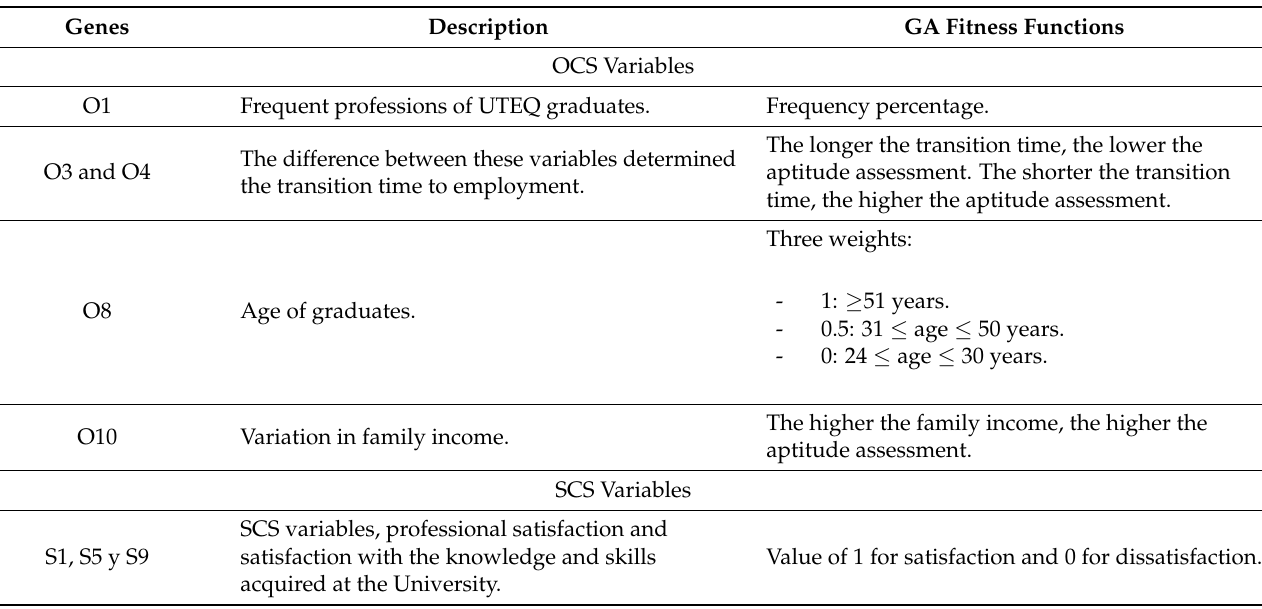
Table 5. GA fitness functions.